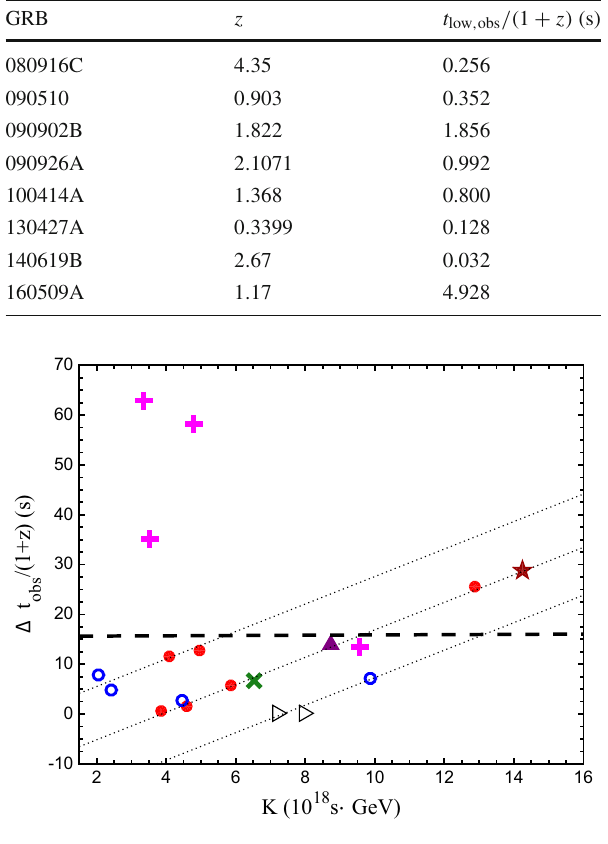
Fig. 6 The Δ t obs /( 1 + z ) – K plot for Band-Obs using Criterion 2. The dashed line marks the fit of all points, while the dotted lines were sug- gested in Refs. [7,8]